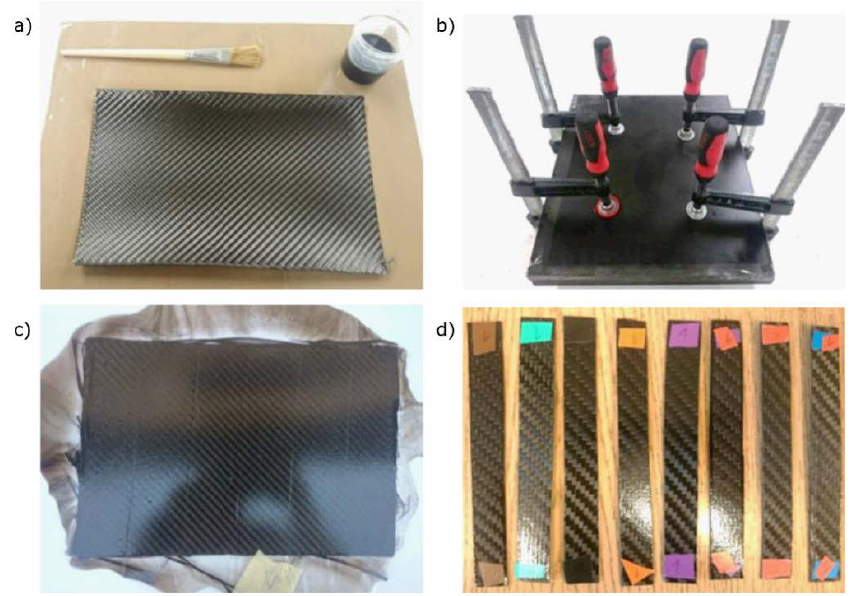
Figure 1. Stages of sample preparation: ( a ) preparation for the lamination process, ( b ) hardening of the laminate under pressure, ( c ) hardened composite, and ( d ) cut and marked samples for